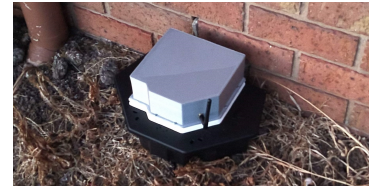
Figure 1. RatSpy fitted to a typical bait